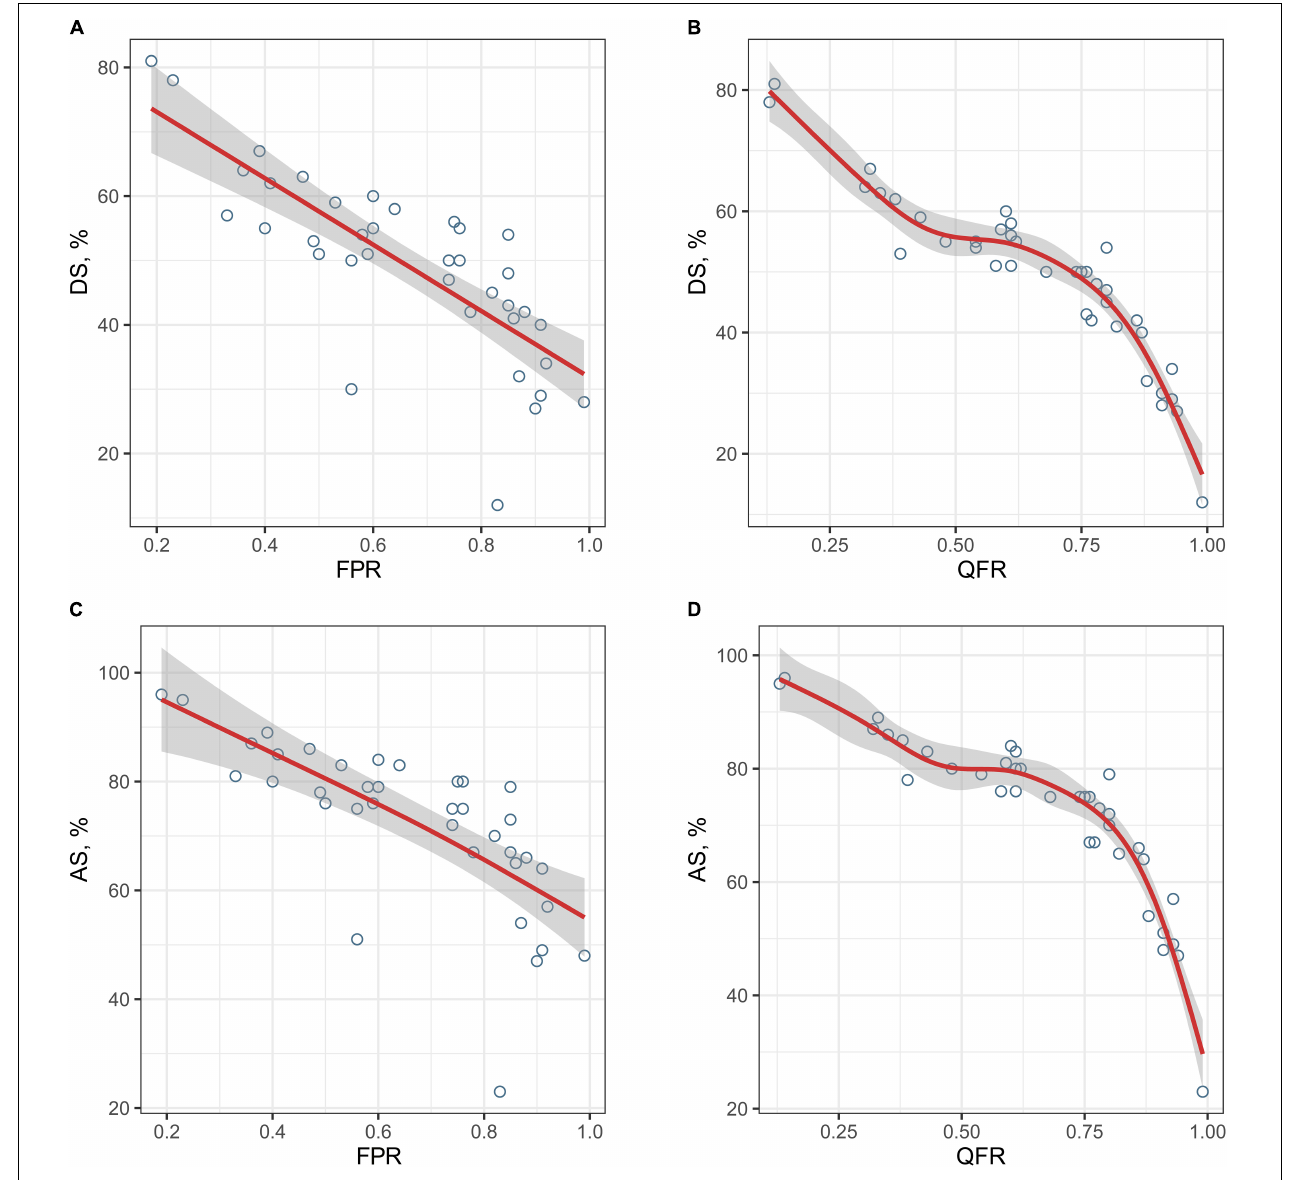
FIGURE 3 | The relationships between the degree of stenosis and FPR or QFR. The fitted curves demonstrate the relationships between the degree of stenosis and FPR or QFR ( A , DS% and FPR; B , DS% and QFR; C , AS% and FPR; and D , AS% and QFR). FPR, fractional pressure ratio; QFR, quantitative flow ratio; DS, diameter stenosis; AS, area stenosis.